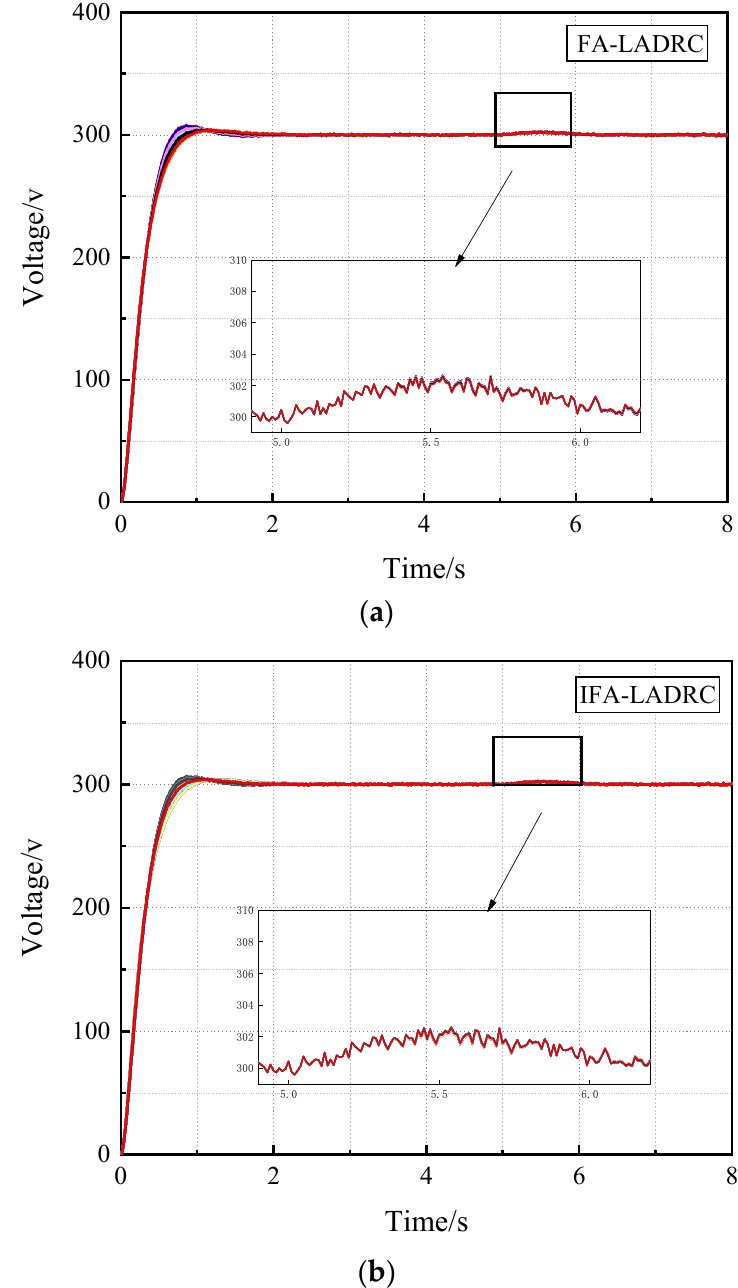
Figure 13. Monte Carlo experiment of ( a ) FA-LADRC and ( b ) IFA-LADRC control methods, wherein the lines in different colors denote system voltage outputs after the addition of a random disturbance within [20%, − 20%] (the same below).